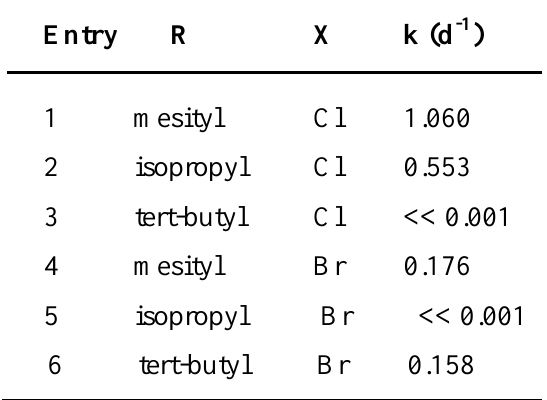
Table 5. Rate constants of the H-D exchange in methanol- d